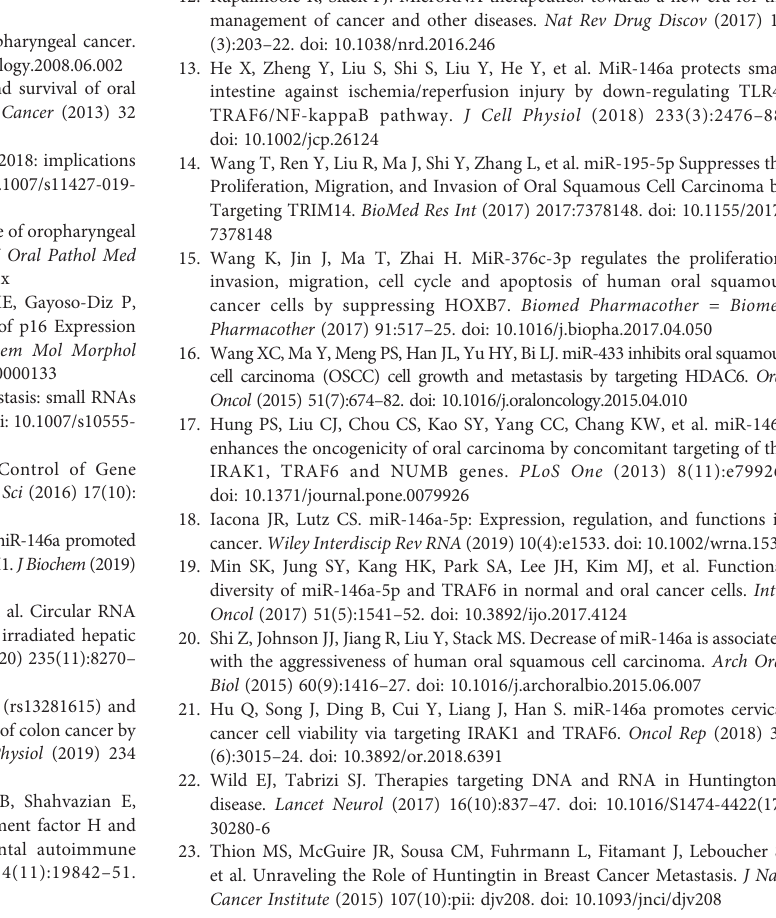
SUPPLEMENTARY FIGURE 1 | Scheme of OSCC development in miR-146a knockout mice. SUPPLEMENTARY FIGURE 2 | The knockdown of miR-146a inhibited the OSCC cell invasion in transwell assay. (A) Representative microscopic images of OSCC cellinvasion. (B) Quantitative analysisof invasive cells.Data are presented as mean ± SD form three independent experiments in triplicate. Signi fi cant effect of the miR-146a inhibitor treatment, *P < 0.05, NC, negative control. Scale bar: 100 m